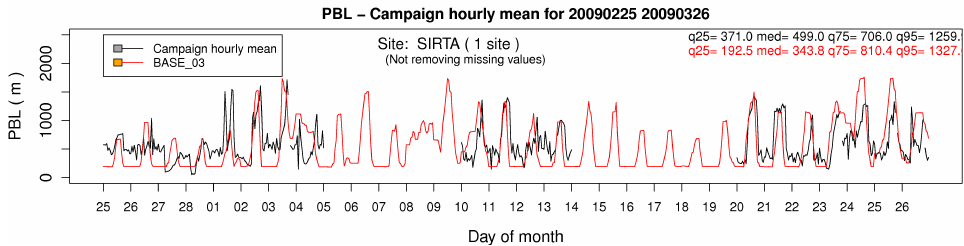
Figure 19. Time series of hourly box plots showing the distribution of the observed and computed PBL height. Observations are in black/grey; modelled values in red/orange. Bars show the 25–75th quantile interval, while the median is displayed by the continuous line. The 25, 50, 75 and 95th quantiles of the whole campaign are reported, too. Comparison of computed and observed box plot time series evaluated at SIRTA